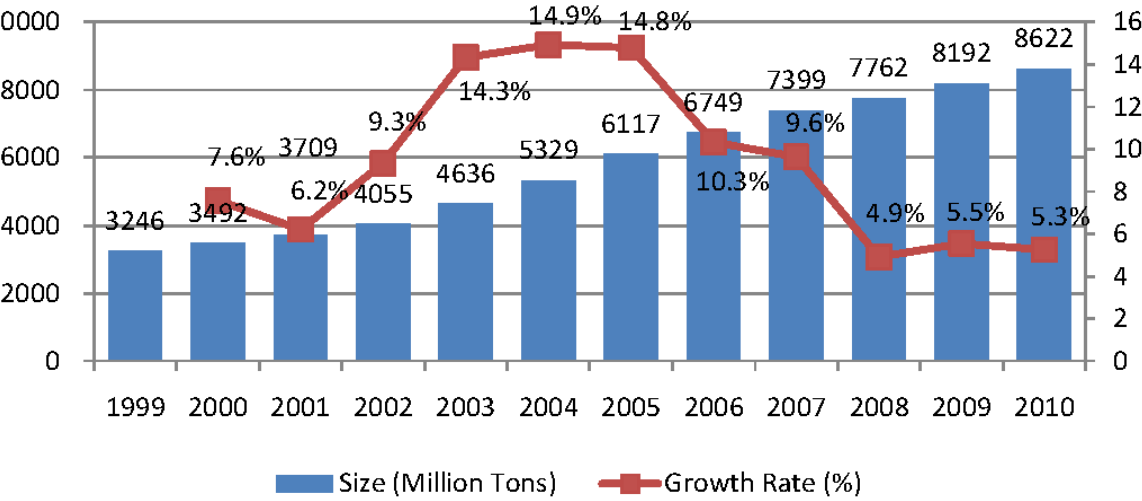
) emissions in China 2